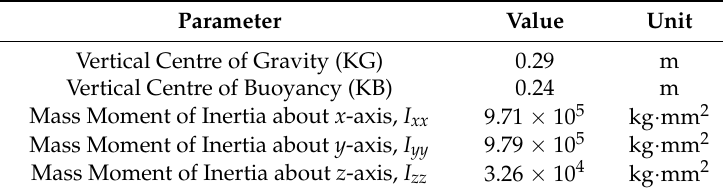
Table 4. Summary of mass and inertia parameters of the TLPWT model.